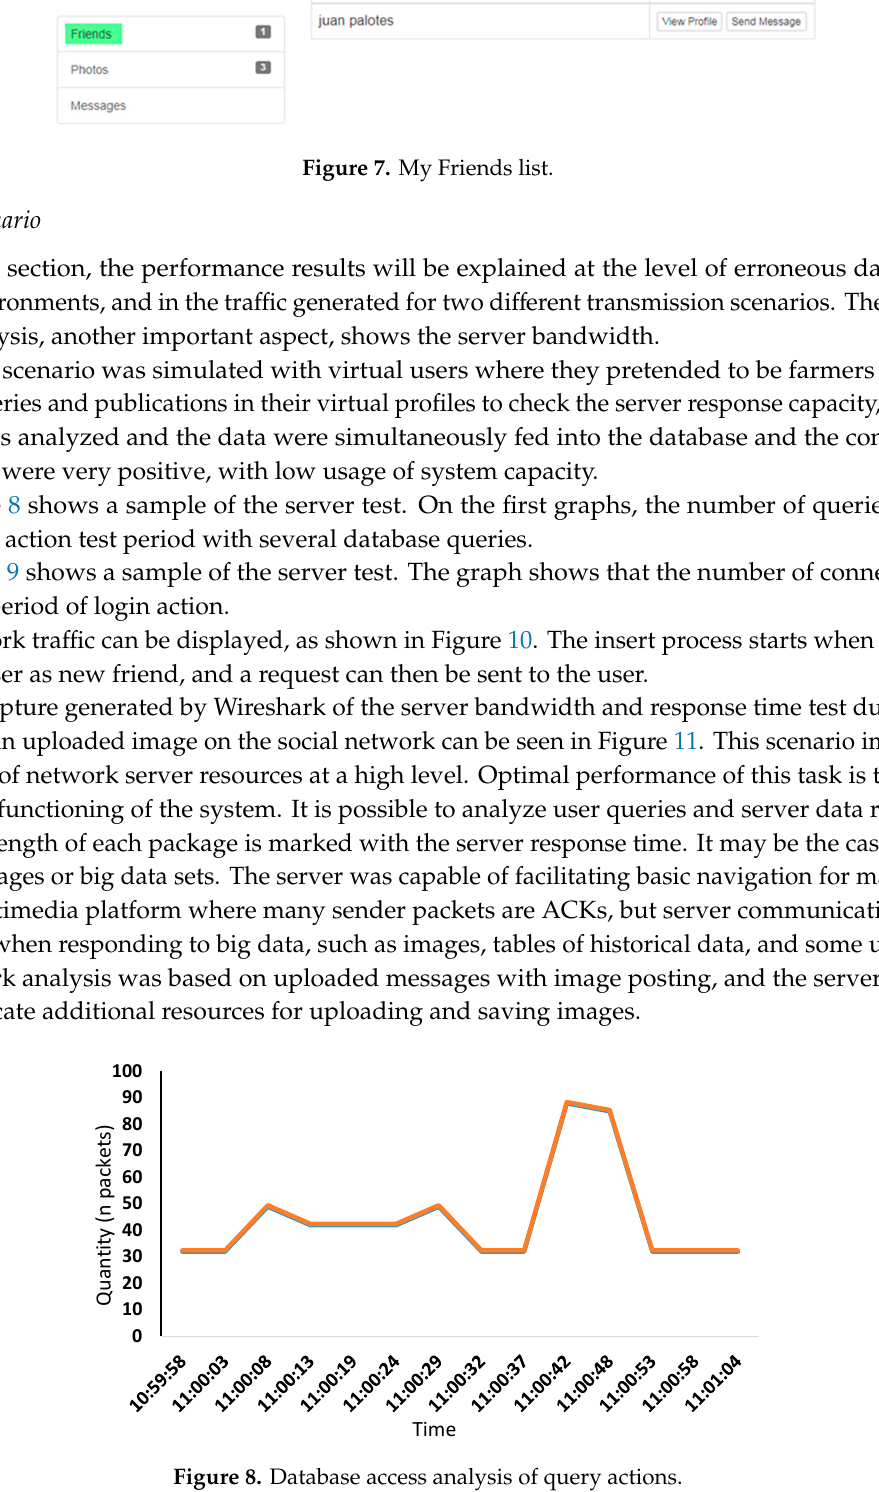
Figure 8. Database access analysis of query actions.